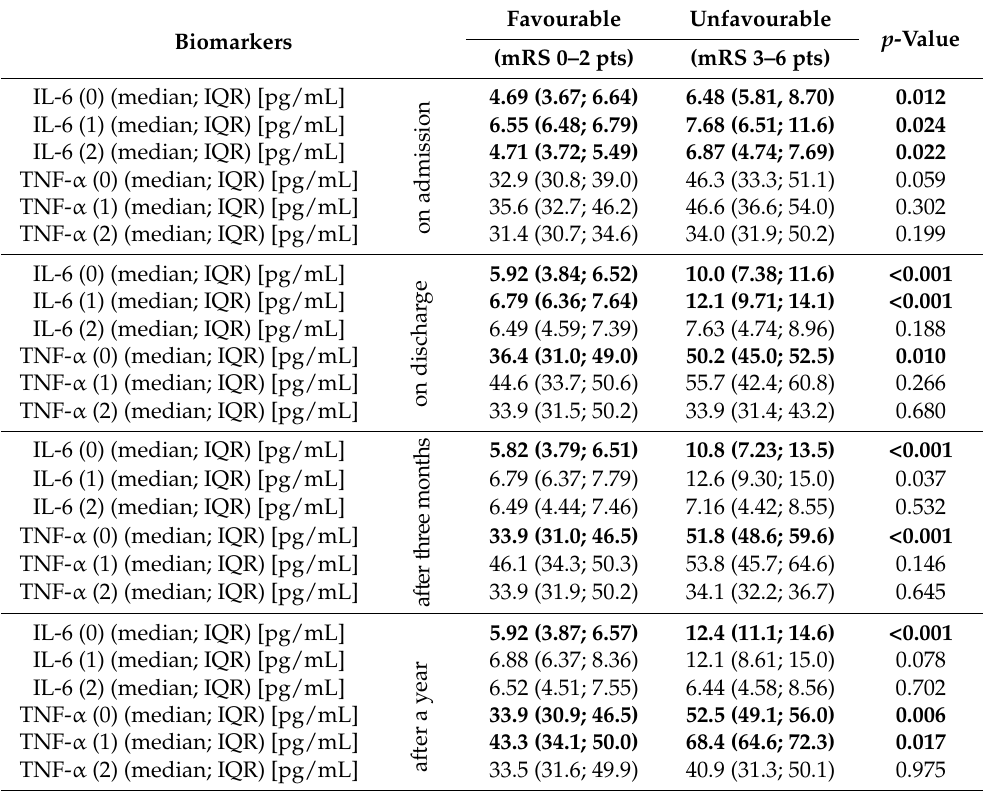
Table 2. Serum concentration of IL-6 and TNF- α of the subgroups of stroke patients with a favourable and an unfavourable outcome after IV thrombolysis at admission, discharge, after 3 months, and after 1 year.